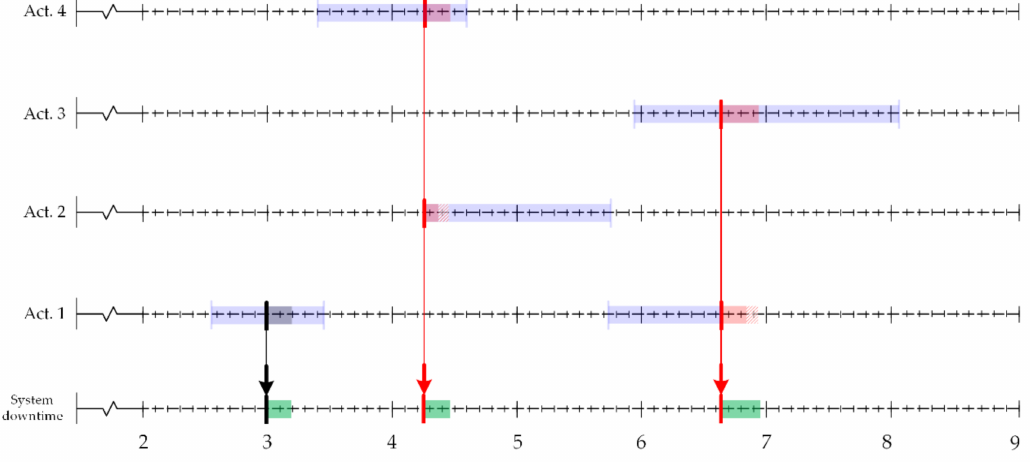
Figure 5. Illustrative example. Grouping scheme for a feasible